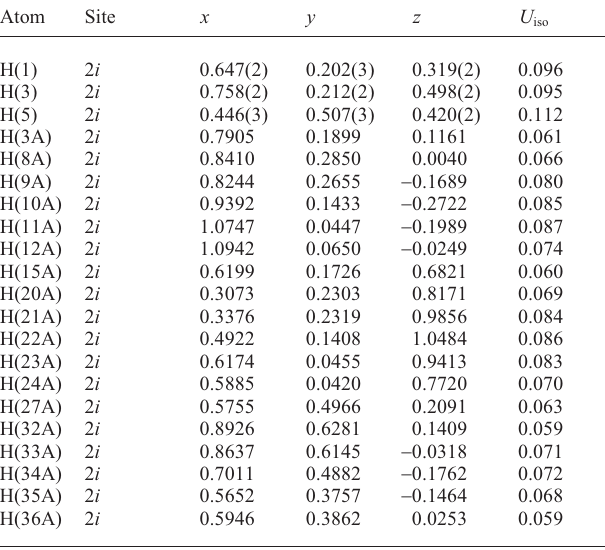
Table 2. Atomic coordinates and displacement parameters (in Å 2 )